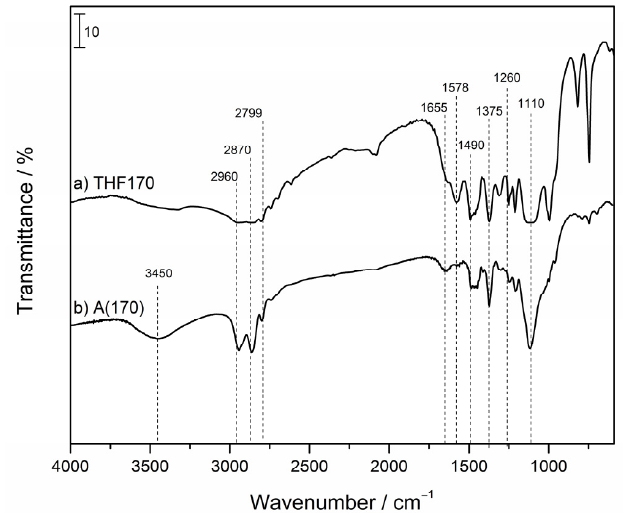
Figure 3. FTIR spectra of undoped OIH sol–gel matrix A(170) and precursor Jeffamine THF170